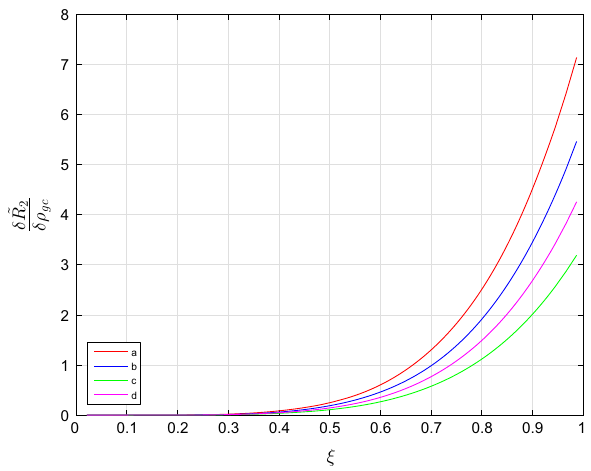
Fig. 3 Case 2: Perturbation through LDP. δ R 2 δρ n = 1 , α = 8 × 10 − 11 , α 1 = 0 . 2, red curve ρ gc = 10 6 . 6 , q = 0 . 4 M (cid:7) , blue curve ρ gc = 10 6 . 6 , q = 0 . 64 M (cid:7) , green curve ρ gc = 10 11 . 8 , q = 0 . 4 M (cid:7) , magenta curve ρ gc = 10 11 . 8 , q = 0 . 64 M